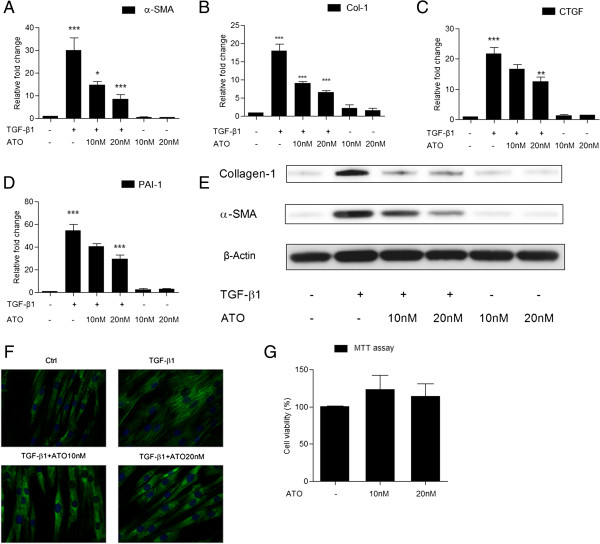
ATO inhibits TGF-β1-induced α-SMA and collagen expression. (A-D) Normal human lung fibroblasts (NHLFs) were serum starved overnight and treated with Arsenic trioxide (ATO) for 24 hrs, then treated with TGF-β1 (1 ng/ml) for 24 hrs. α-SMA, Collagen-1, PAI-1 and CTGF mRNA expression levels were evaluated by TGF-β1 and ATO inhibited TGF-β1’s effect. (E) TGF-β1-induced α-SMA and collagen-1 protein expression was blocked by ATO in NHLFs. (F) Immunofluorescent staining showed TGF-β1-induced α-SMA fiber formation was reduced by ATO. (G) An MTT assay showing that ATO does not affect NHLF viability. RT-PCR Data represent results from three independent experiments with duplicate repeats. Western blot and immunofluoresent staining data represent consistent trend in three independent repeats with the best image quality. *P value < 0.05, **P value <0.01, ***P value < 0.001.